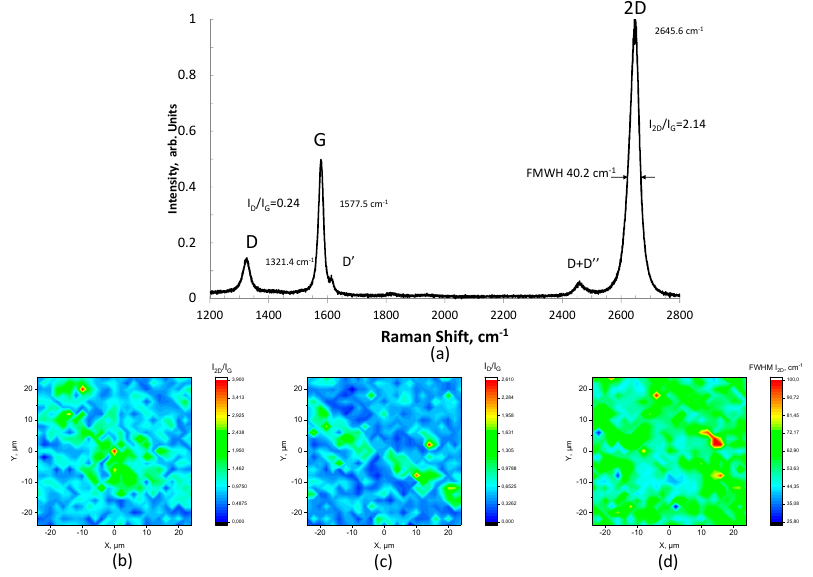
Figure 8. Raman spectroscopy in confocal mode in air with the backscattering configuration using 632.8 nm laser excitation at room temperature. Copper foil size 1.35 × 1.70 cm 2 , current intensity for annealing I = 268 A and for growth I = 288 A, and frequency f = 215 kHz. Temperature was fixed at 1040 °C, and annealing and growth time were 500 s and 150 s, respectively: ( a ) Typical Raman spectra of transferred graphene onto SiO 2 /Si substrate; ( b ) Raman mapping of I D /I G ratio; ( c ) Raman mapping of I 2D /I G ratio; ( d ) Raman mapping of 2D bandwidth (FMWH) unit is cm -1 . To elucidate the nucleation step, SEM analysis was performed on graphene grown on polycrystalline copper after only 5s of methane addition. The nucleation of graphene occurs after the supersaturation of active carbons, and then domain growth is started.